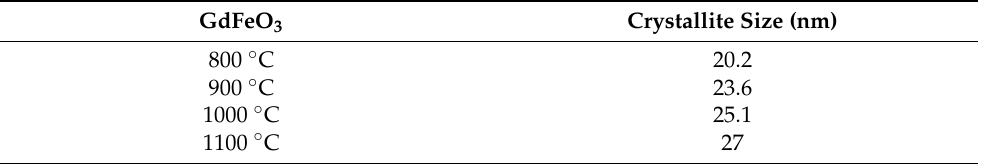
Table 1. Crystallite sizes of the gadolinium